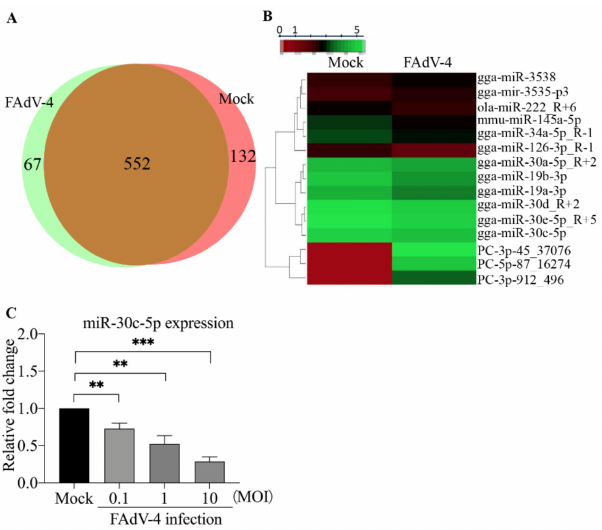
Figure 1. Infection of LMH cells with FAdV-4 strain HuBWH decreases gga-miR-30c-5p expression. ( A ) Venn diagram represents the numbers of miRNAs coded by FAdV-4 and changed miRNAs in LMH cells 24 h after infection with FAdV-4 at an MOI of 1. ( B ) The heat map illustrating the expression profiles of 12 miRNAs in LMH cells with FAdV-4 infection and 3 miRNAs encoded by FAdV-4. The red color stands for the decreased expressions of miRNAs while the green for increased expressions of miRNAs. ( C ) LMH cells were mock-infected or infected with FAdV-4 strain HuBWH at an MOI of 0.1, 1, or 10. Twenty-four hours after FAdV-4 infection, the expression levels of gga-miR-30c-5p were examined by qRT-PCR. The expression of U6 was used as an internal control. The relative levels of gga-miR-30c-5p expression were calculated as follows: gga-miR-30c-5p expression in FAdV-4-infected cells/that of mock controls. Data are representative of three independent experiments and presented as means ± SD. (*** stands for p < 0.001; ** for p <